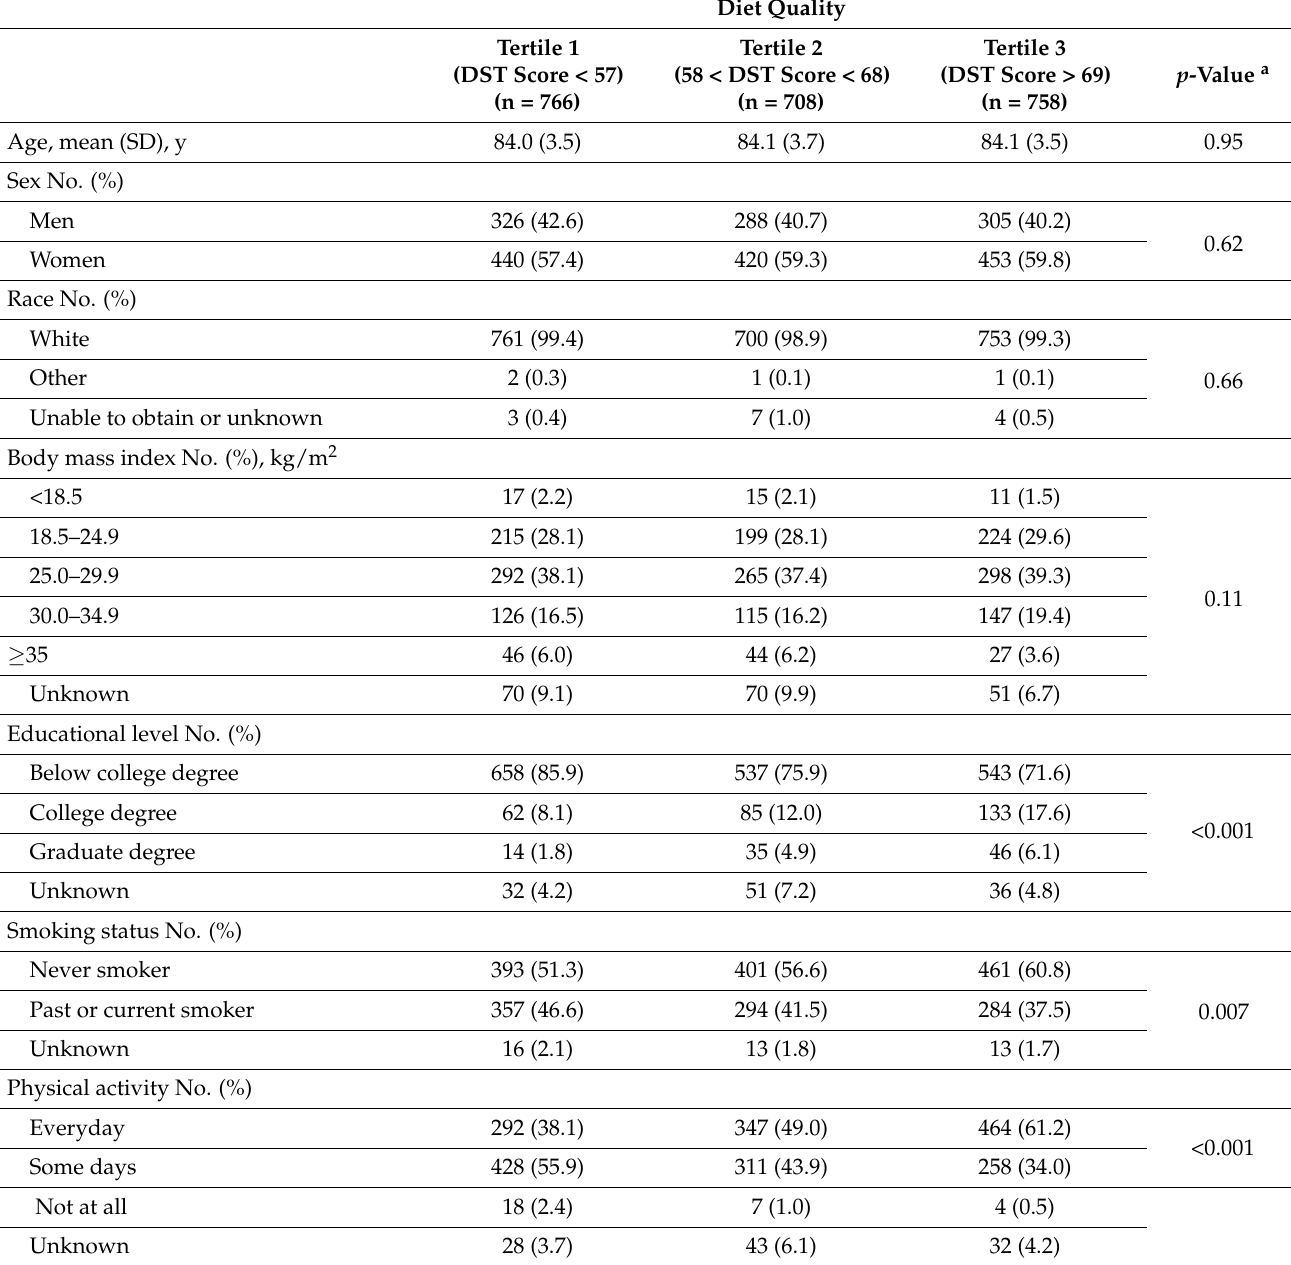
Table 1. Baseline Characteristics Among Geisinger Rural Aging Study (GRAS) Participants by Diet Quality